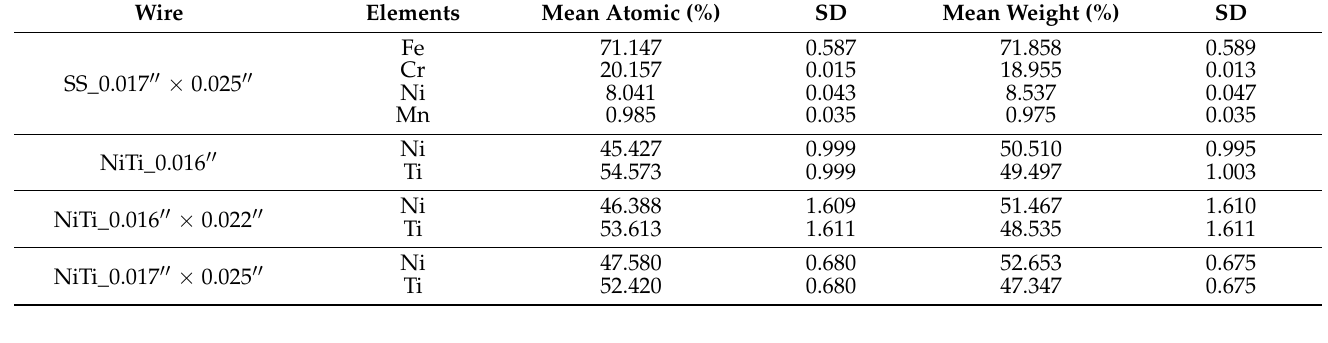
10 of 23 Table 2. The alloy composition mean values of the four different types of wires. Wire